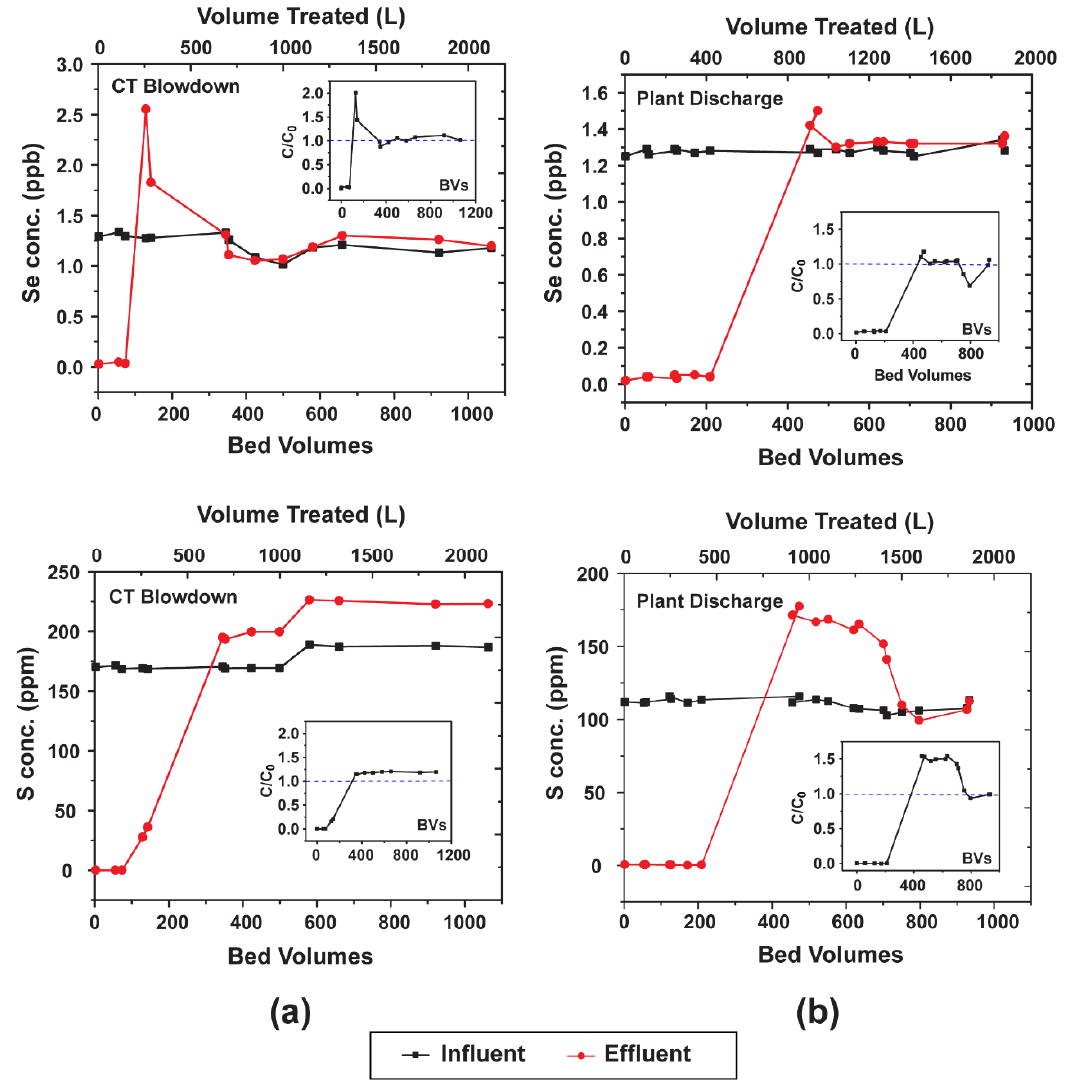
Figure 4. Se and S breakthrough curves from 2” (5.08 cm) diameter column test (testbed) with granular LDH as bed material to treat ( a ) cooling tower blowdown and ( b ) plant discharge wastewater. Insets